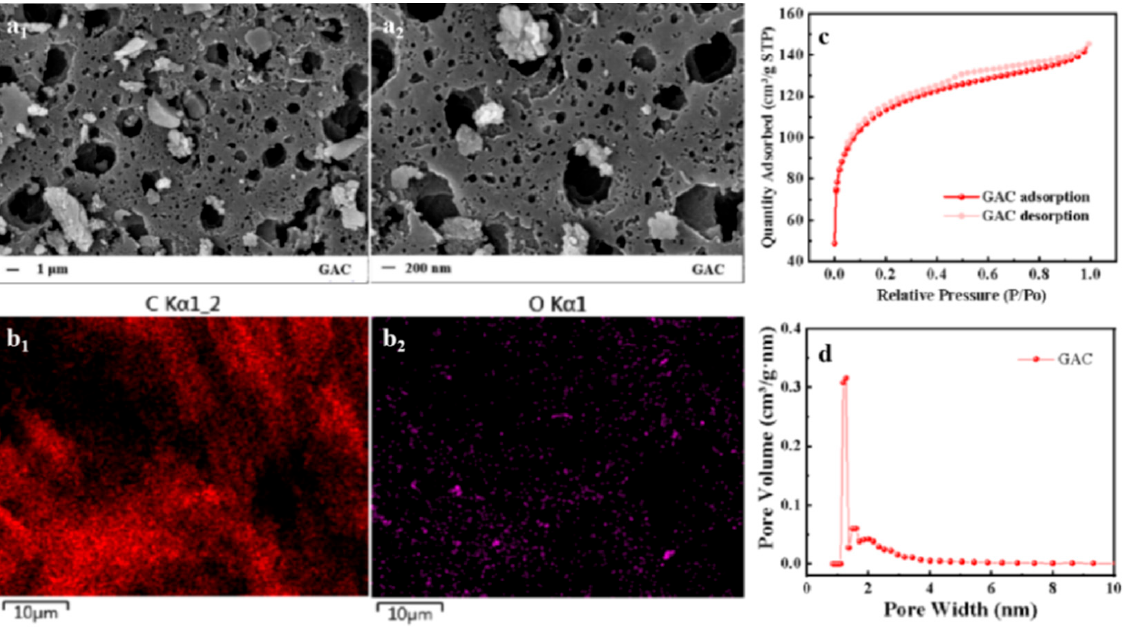
Figure 1. SEM ( a 1 , a 2 ), EDS ( b 1 , b 2 ), N 2 adsorption–desorption isotherms ( c ) and pore size distribution ( d ) images of GAC.